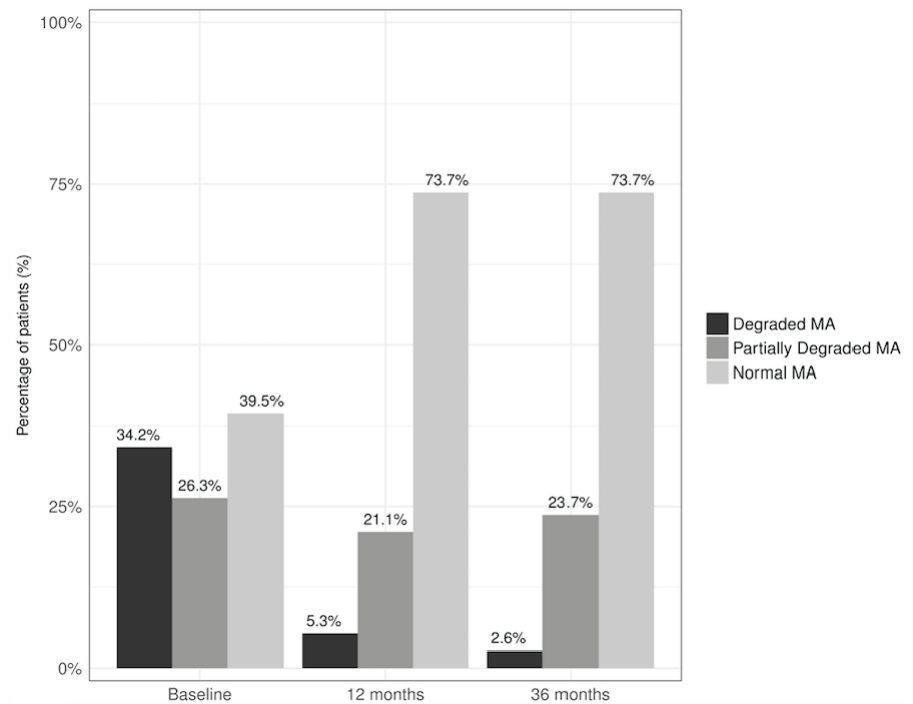
Figure 1. Percentage of patients with normal, degraded and partially degraded bone microarchitecture (MA) at baseline, 12 and 36 months after RYGB.